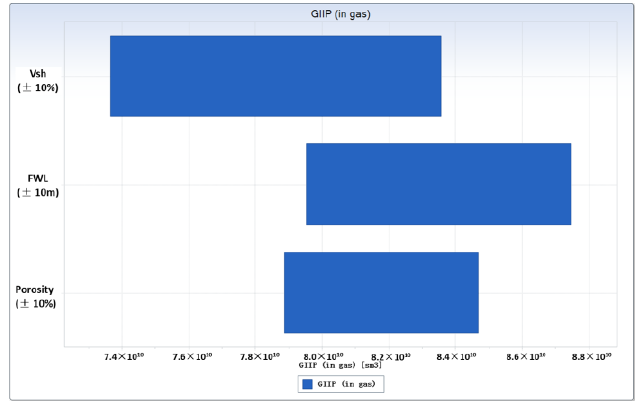
Figure 27. Subsurface uncertainties revealed by the geologic genesis analysis and the static reservoir model. The shale volume is the largest subsurface uncertainty and the variations in free water level and porosity play an important role in subsurface uncertainties.